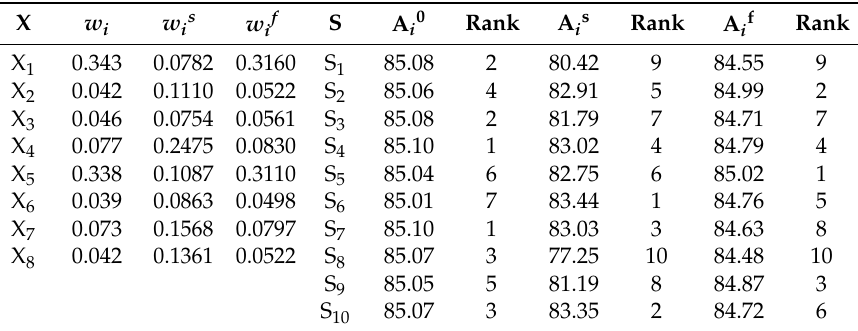
Table 7. Comparison of the Two